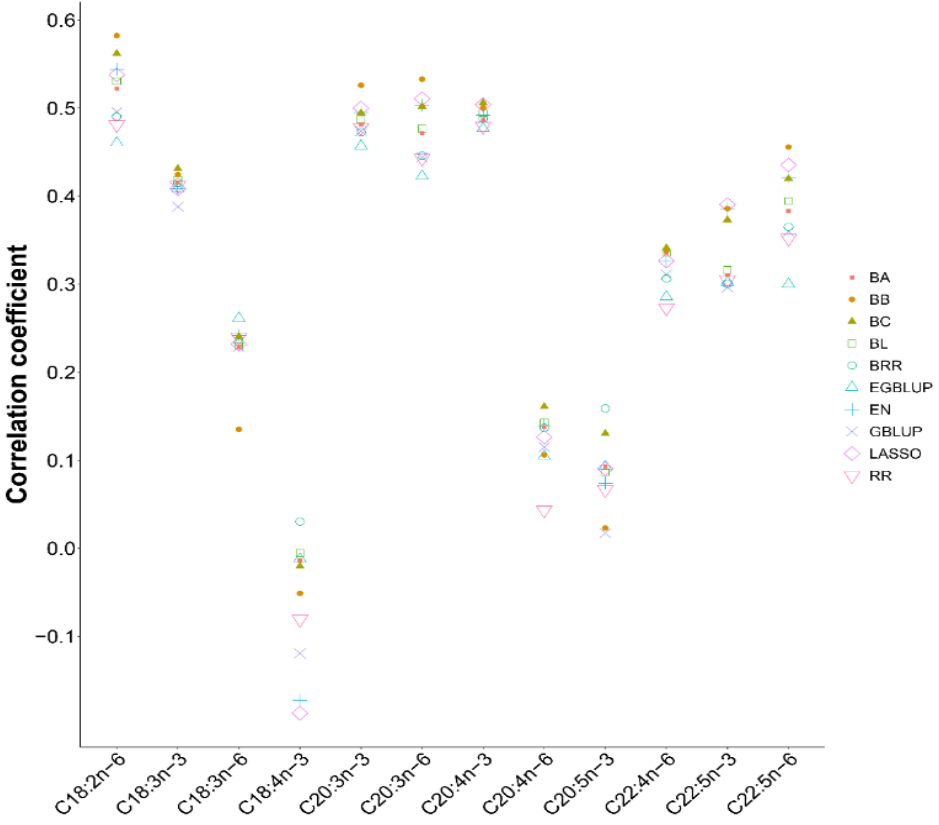
Figure 3. Distribution of the mean Pearson correlation CVs for each PUFA using ten methods with 25 cSNPs in fads2b and elovl5b . The CV was calculated between the actual contents and the predicted contents of each PUFA across individuals in the validation group.